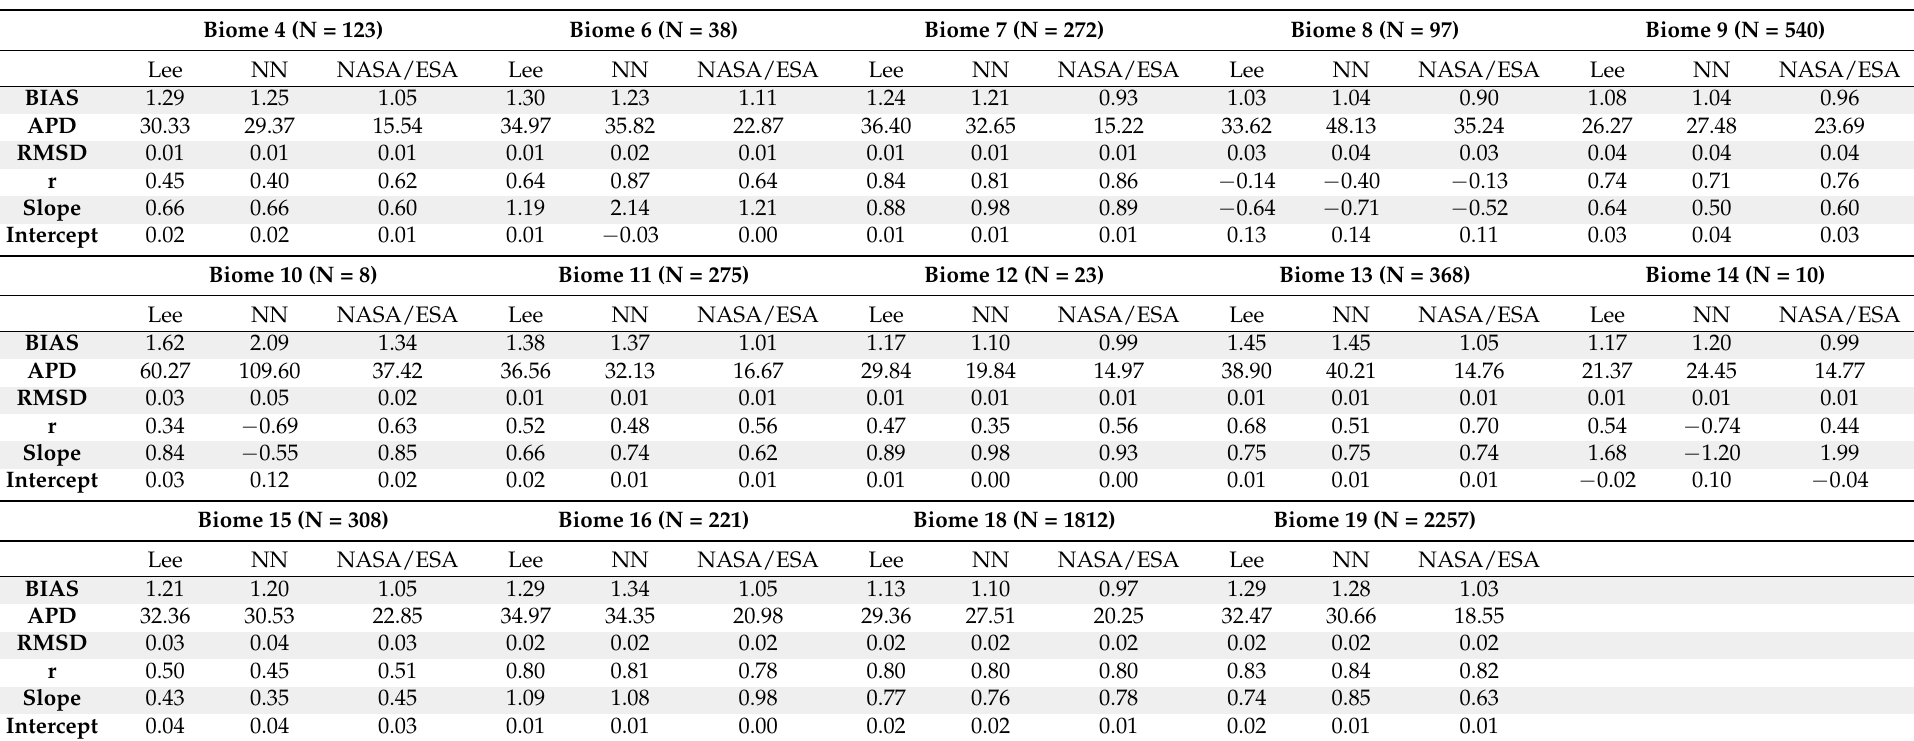
Table 6. Summary statistics at λ = 490 nm for each of the biomes defined in Table A2, with all sensors grouped together. The NASA empirical algorithm (see Methods section) was applied for the MODIS and the VIIRS sensors, whereas the ESA empirical algorithm was applied on the OLCI sensors. As they are both empirical algorithms, they were grouped together for the overall statistical analysis. In parentheses are the numbers of matchups between K d ( 490 ) float and K d ( 490 ) R rs in each of the biomes for each algorithm. For the definition of the bias, APD, RMSD and r (Pearson’s correlation coefficient) see the Methods